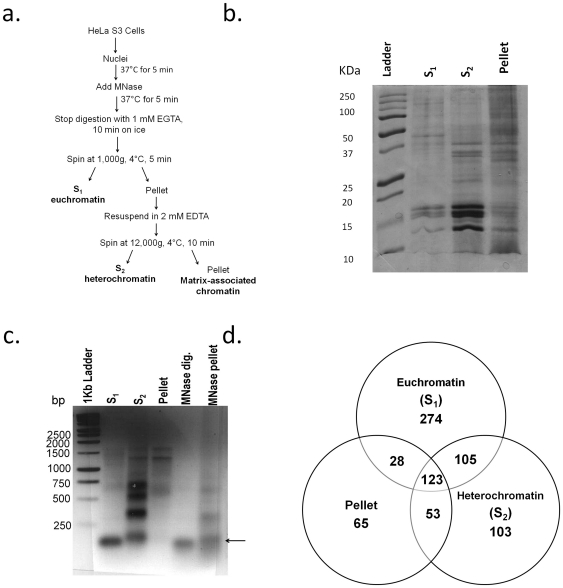
Crude separation of euchromatin and heterochromatin.(a.) Purification diagram, (b.) One-dimensional SDS-PAGE analysis of euchromatin (S1), heterochromatin (S2) and pellet fractions. Proteins in these fractions were separated by one-dimensional 15% SDS-PAGE gel and stained with Coomassie Brilliant Blue. Loading is approximately 10 ug of protein per lane, (c.) DNA gel (2% agarose) of S1, S2, and pellet fractions. S1 is composed mostly of mononucleosomes running at approximately 150 bp (black arrow). S2 and pellet fractions contain longer pieces of DNA corresponding to more compact chromatin. Total MNase digestion is shown for comparison, (d.) Venn Diagram indicating the number of proteins detected in one, two or all three fractions.